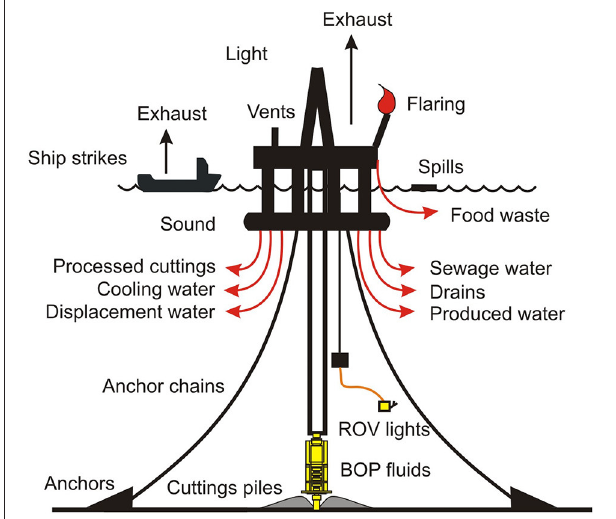
FIGURE 3 | Diagram of impacts from typical deep-sea drilling